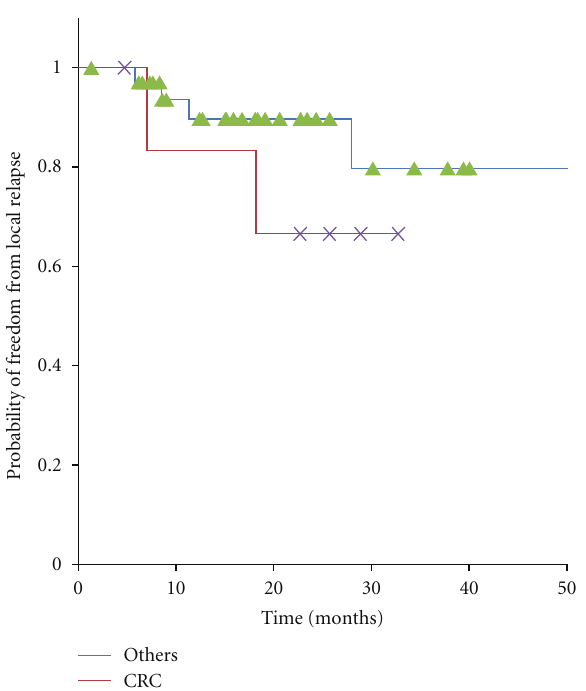
Figure 2: Kaplan-Meier curves for local control in 42 patients with oligo-recurrence cancer in the lung, cancers from colorectal cancer and ones from other origins.